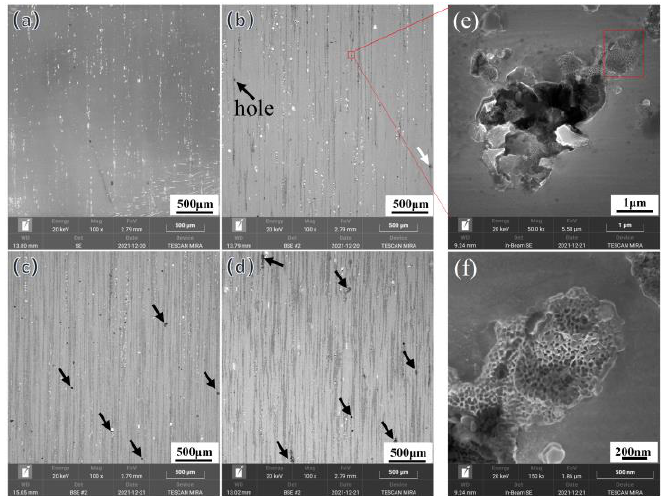
Figure 7. SEM image of x% CNTs/Al-Cu-Mg-Si composites. ( a ) Al-Cu-Mg-Si alloy; ( b ) 1.5 wt% CNTs/Al-Cu-Mg-Si composites; ( c ) 2.0 wt% CNTs/Al-Cu-Mg-Si composites; ( d ) 3.0 wt% CNTs/Al- Cu-Mg-Si composites; ( e , f ) High magnification morphology at holes.